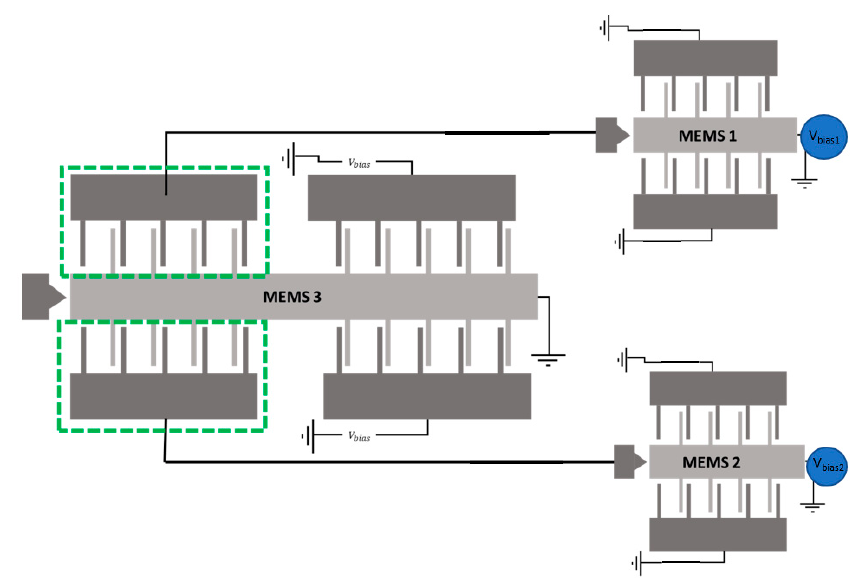
Figure 8. A schematic for the customized MEMS CTRNN to perform waveform classification. The schematic highlights the coupling through fingers between the three MEMS.